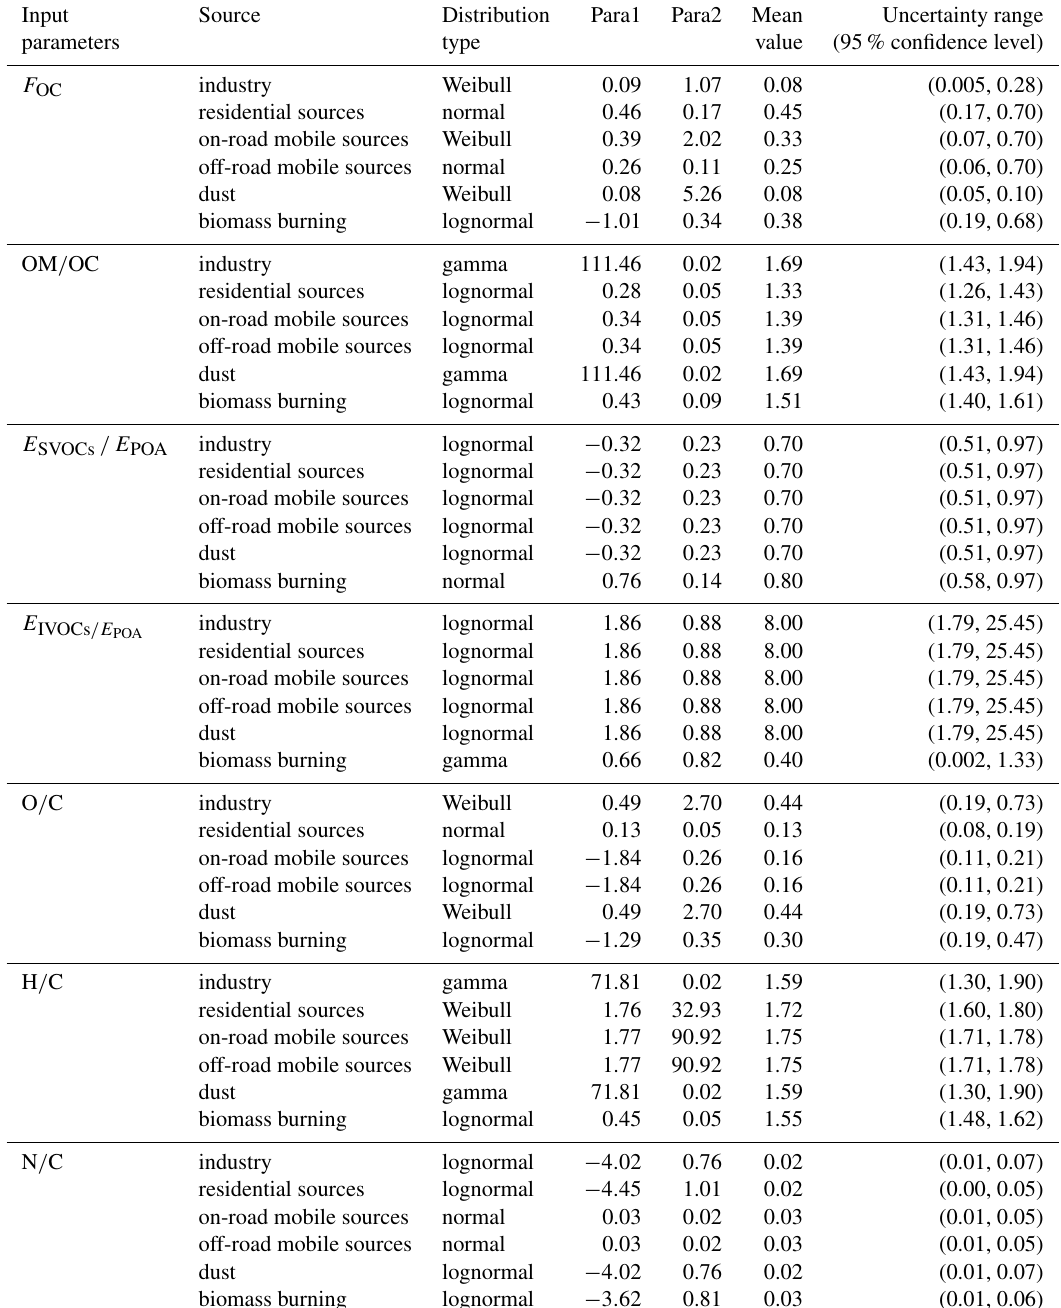
para1: the mean for normal, the mean of lnx for lognormal, and the scale parameter for gamma and Weibull distributions. para2: the standard deviation for normal, the standard deviation of lnx for lognormal, and the shape parameter for gamma and Weibull